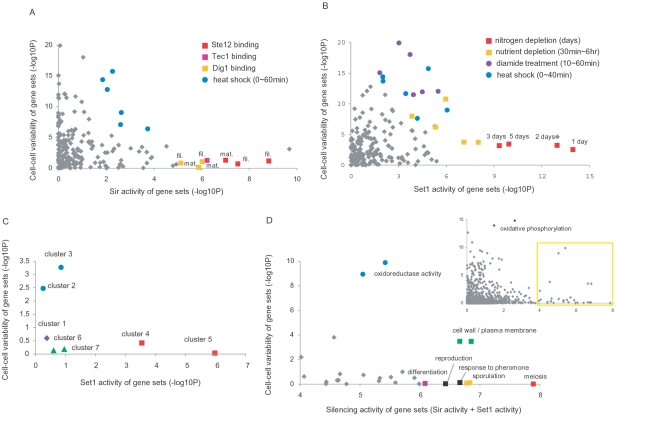
Effects of silencing strength on stress response.The silencing activity and expression noise of genes in a defined group were compared with the rest of genes and its statistical significance was reported as –log10 (P value). (A–B) Analysis for the 200 stress-responsive gene sets (Table S6). The threshold was 5.301 (α = 0.001). (A) Plot of expression noise as a function of Sir-complex activity. Gene sets shown as rectangles contain the target genes of Ste12, Tec1, and Dig1 under the condition of filamentation inducing (fil.) or mating inducing (mat.). (B) Plot of expression noise as a function of Set1 activity. (C) Analysis of sporulation gene clusters. Cluster 1 corresponds to genes induced at early time points and cluster 7 at late time points. Cluster 4 contains known key genes required for pre-meiotic processes and cluster 5 contains meiosis-specific factors required for proper sporulation. The threshold was 3.85 (α = 0.001). (D) Analysis for Gene Ontology categories. The sum of the Sir2/3/4 score and Set1 score was used on the x-axis. Among a total of 1157 categories (inset), those for which combined silencing activity is greater than 4 (circumscribed in yellow) are enlarged (listed in Table S7). The threshold was 6.063 (α = 0.001).